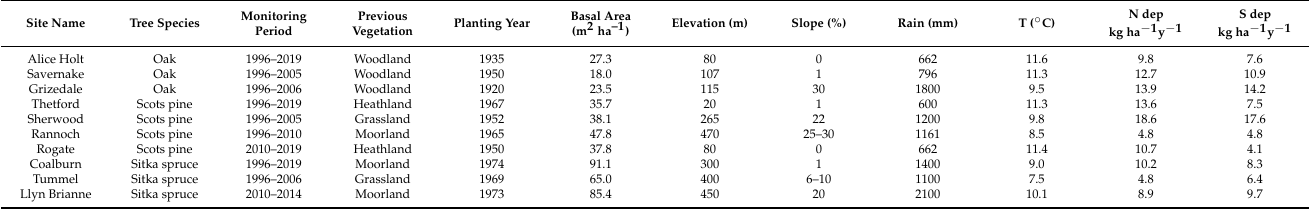
Table 1. Site and climatic characteristics of 10 Intensive Forest Monitoring Level II sites in the UK. Basal area was measured in 1995. Averaged annual rainfall, temperature and total nitrogen and sulphur deposition over the monitoring period at the sites are